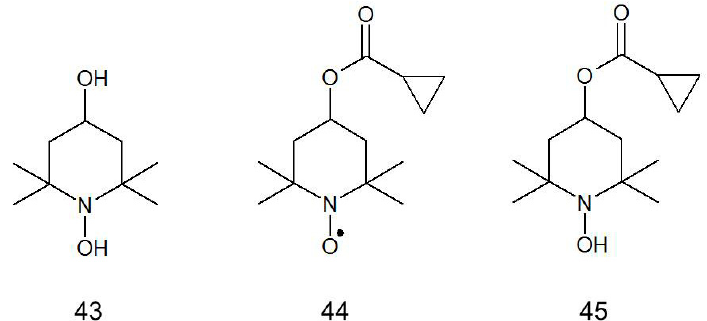
Figure 11. Nitroxides and hydroxylamines used in age-related macular degeneration.